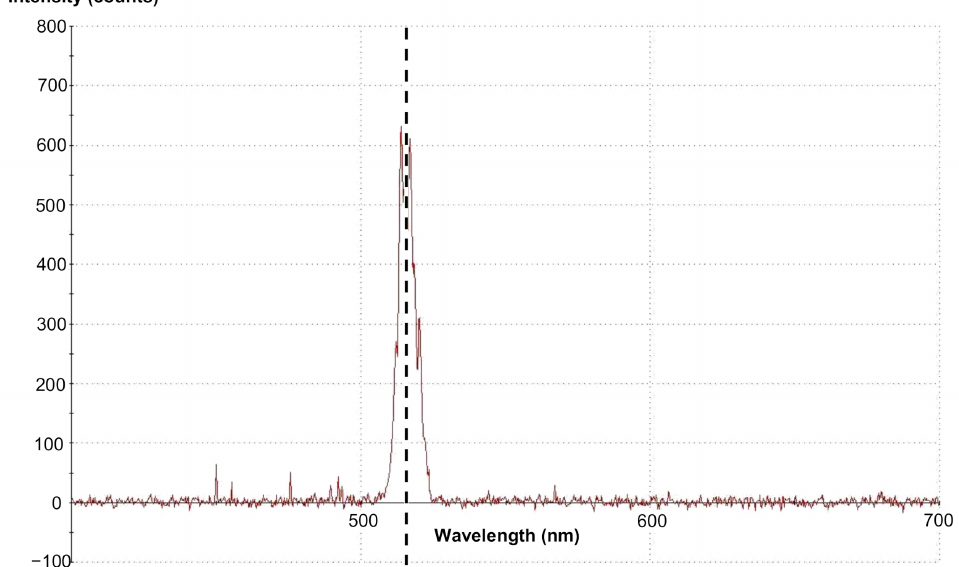
Figure 6. The spectrum of the TH wave generated in GaN